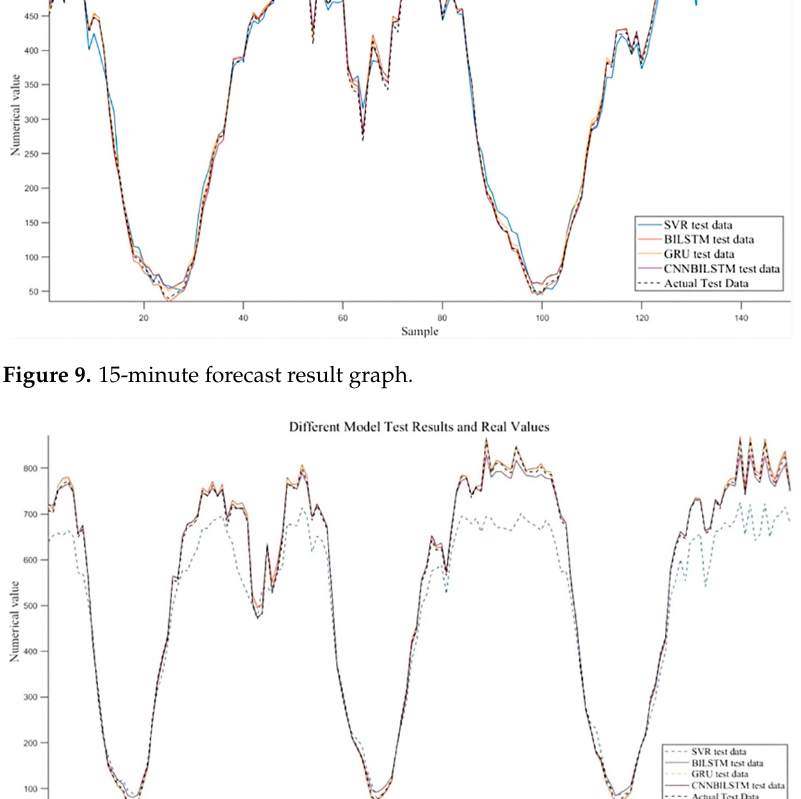
Figure 10. 30-minute forecast result graph.